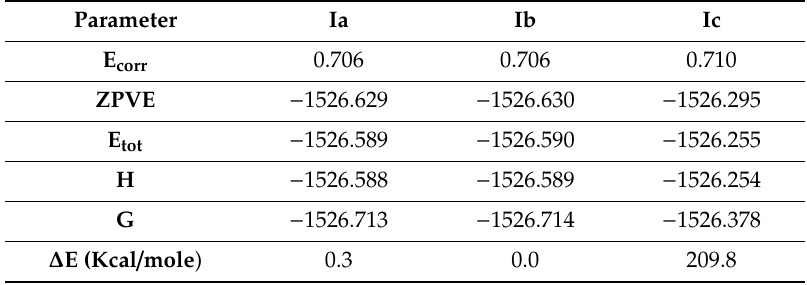
Table 4. Thermal parameters (Hartree / Particle) of estimated geometrical isomers, Ia – c .